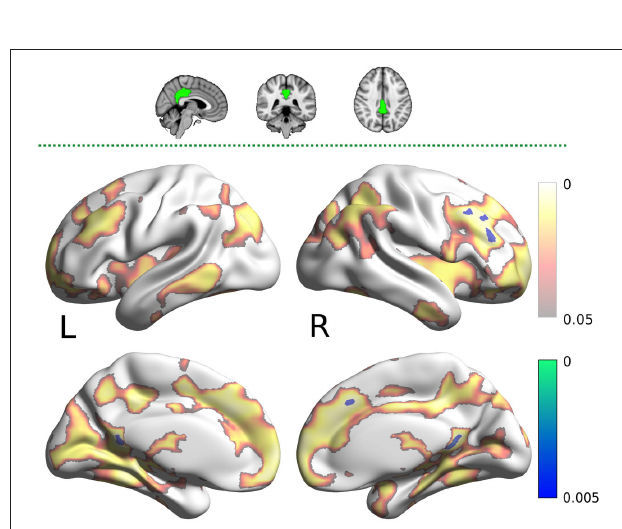
FIGURE 4 | Results for the posterior cingulate cortex (PCC) mask (two dimensional image on top, with mask shaded in green, centered at x = − 28 , y = − 24 , z = − 14 ). Warm colors present the cluster of decreased connectivity in carnosine/anserine subjects (multiple comparison FWE corrected, p < 0.05). Bluish colors present the areas in which carnosine/anserine subjects have decreased connectivity as compared to placebo with additional Bonferroni correction ( p < 0.005). Left (L) and right (R) hemispheres are presented separately.